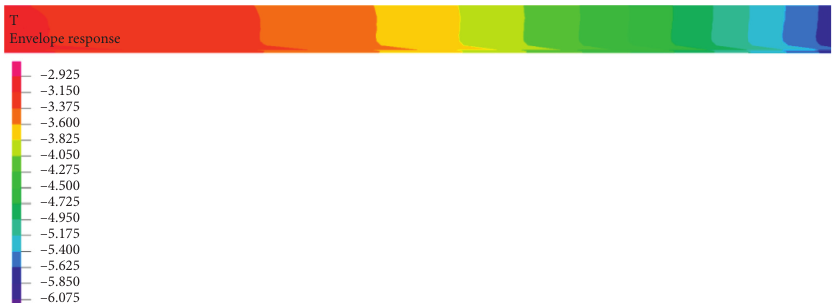
Figure 22: Annual average air temperature distribution outside the lining in the tunnel axis with a thermal conductivity of 0.02W/(m · ° C).